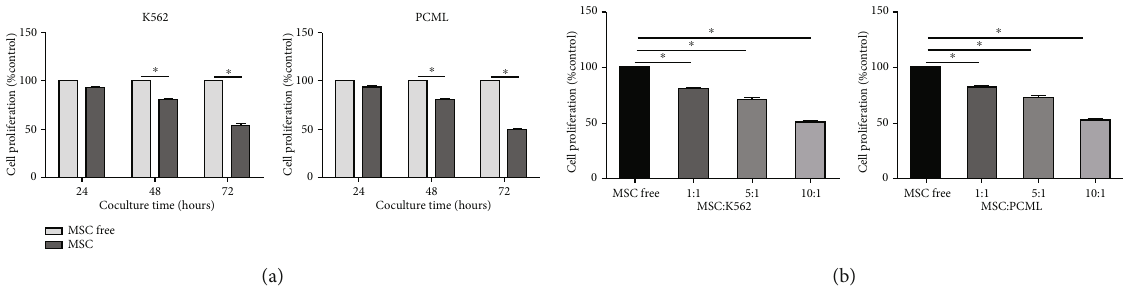
Figure 2: BMMSC inhibit the proliferation of CML cells in vitro. (a) Cell proliferation of K562 cells and PCML cells cocultured with or without di ff erent MSC. (b) K562 and PCML cells were cocultured with hBMMSC at di ff erent ratios (1 :1, 5:1, and 10: 1) for 48h. Then, the proliferation of K562 cells and PCML cells was evaluated. The data were expressed as the mean ± SD of three independent experiments. ∗ p < 0 : 05 Student ’ s t